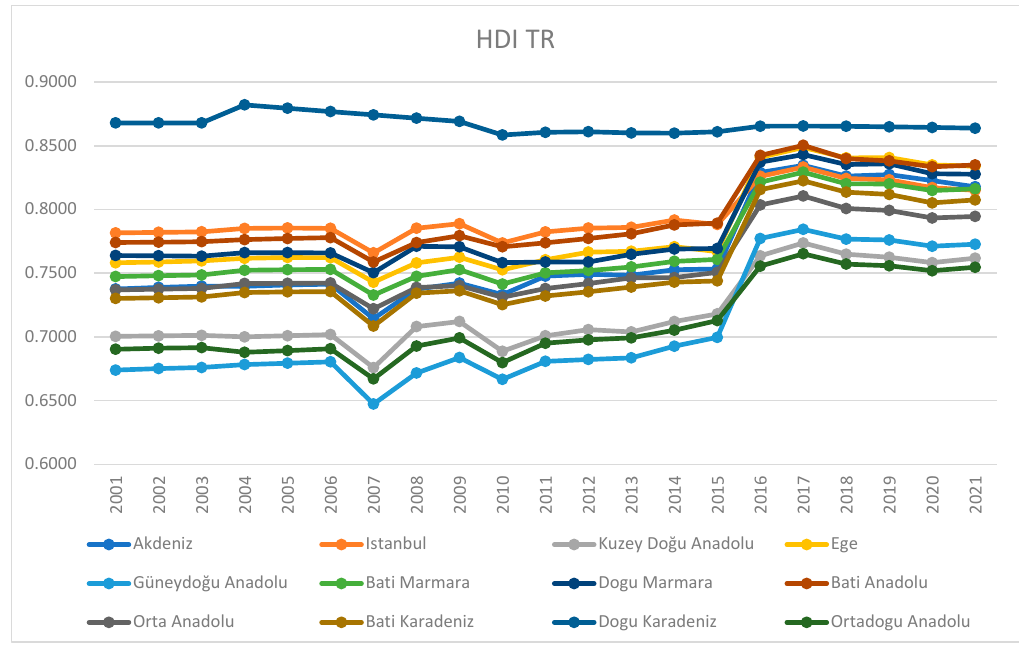
Figure 1. HDI Turkey evolution. Source: Turk Statistical Institute.